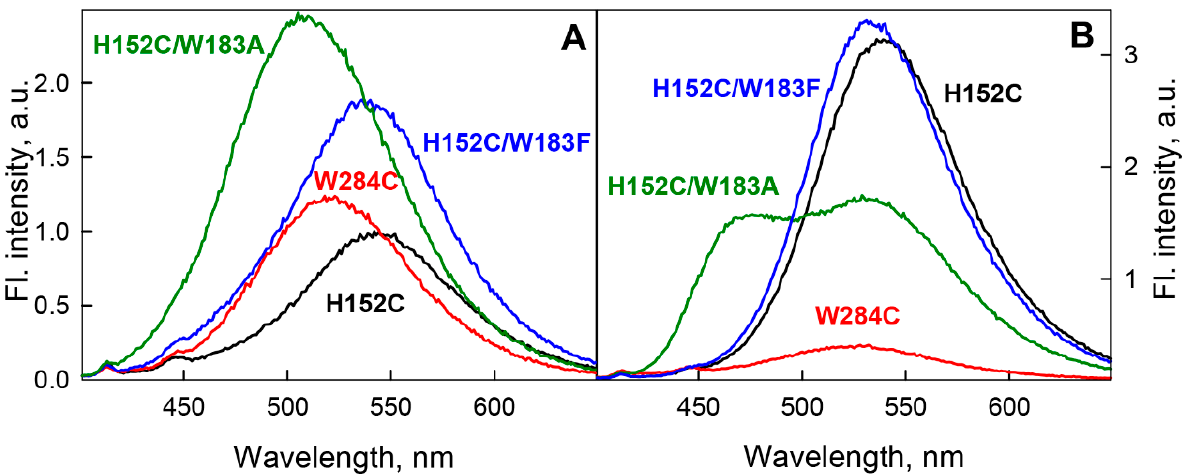
Figure 5. Influence of microenvironmental properties on the fluorescence characteristics of BADAN coupled to various mutant forms of GGBP in the apoform (panel ( A )) and in complex with glucose (panel ( B )). The black, red, blue, and green curves correspond to the spectra of the dye attached to GGBP/H152C, GGBP/W284C, GGBP/H152C/W183F, and GGBP/H152C/W183A, respectively. The BADAN fluorescence intensity is normalized to the fluorescence intensity of the dye attached to the GGBP/H152C apoform. The excitation wavelength was 387 nm.